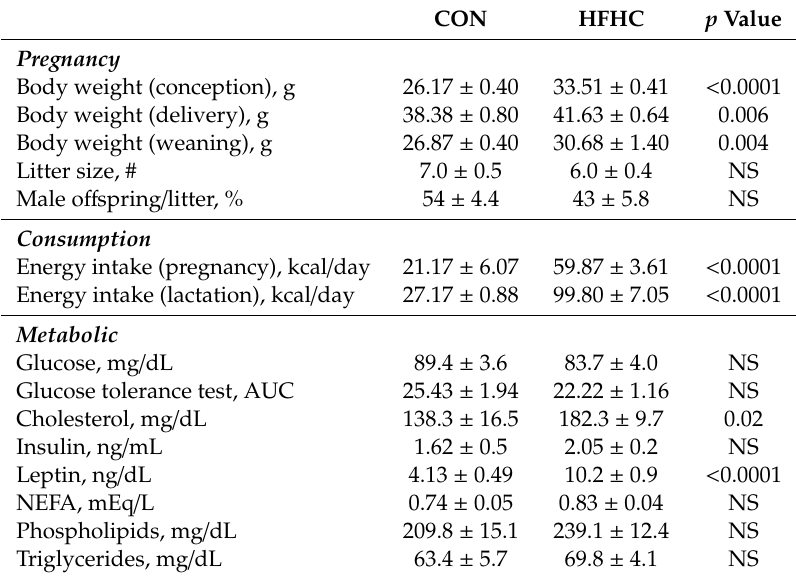
Table 1. Dam Cohort